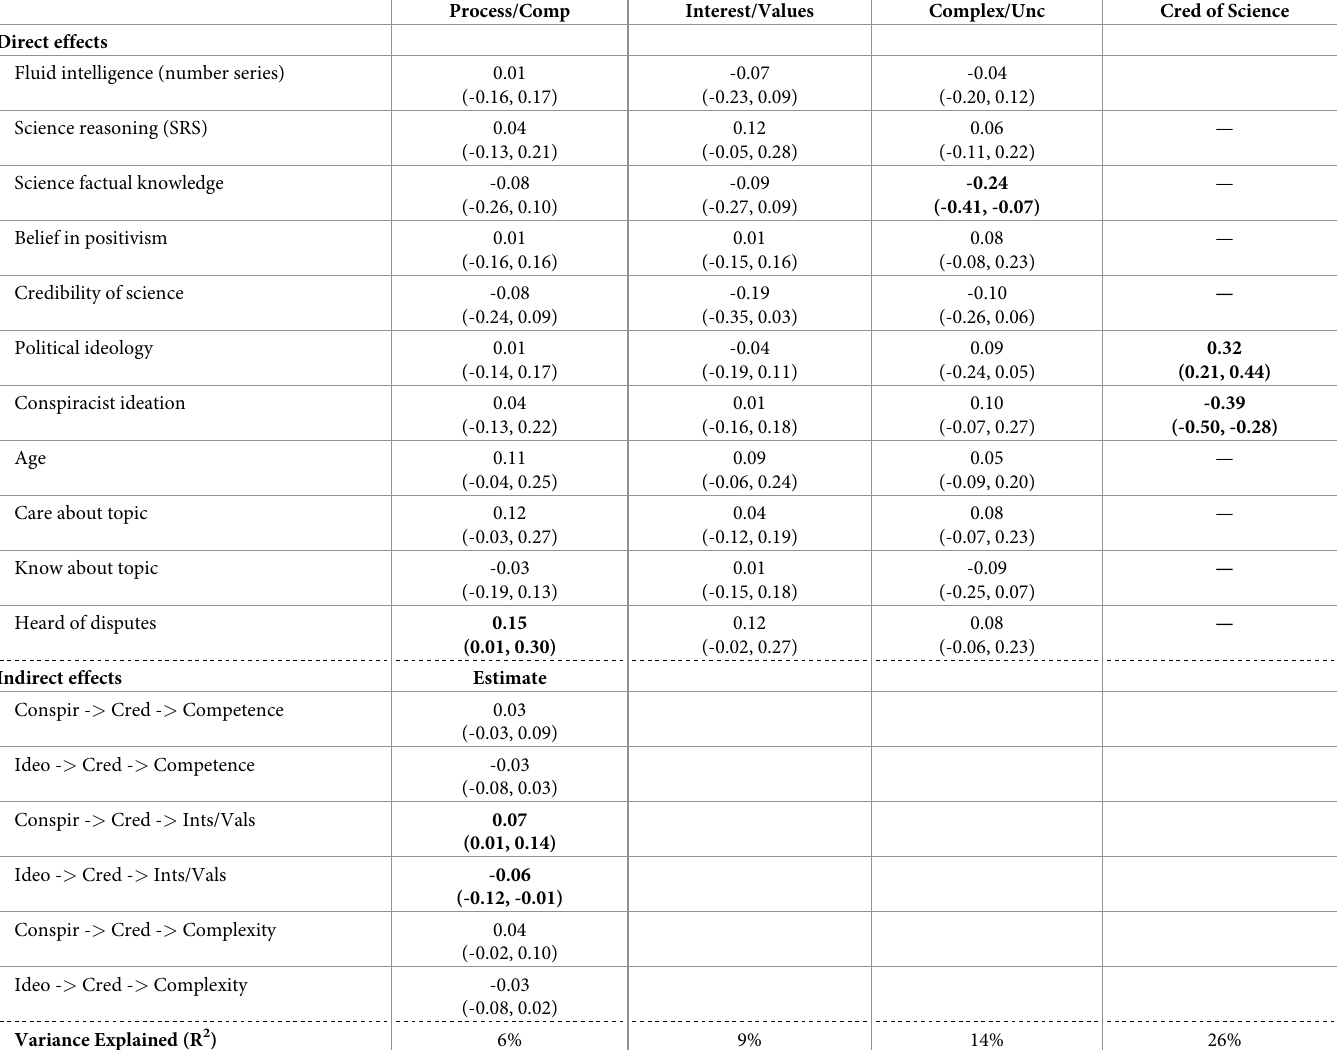
Table 4. Study 2. Direct/Indirect effects from SEM for participants who read the Salt scenario ( N =